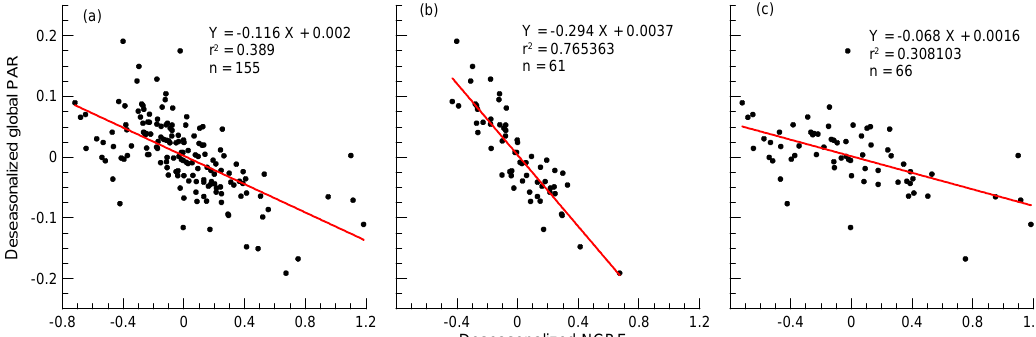
Figure 13. Scatterplot between deseasonalized global PAR and deseasonalized NCRE for all data (a) , for the months November–March (b) , and for the months May–September (c) . Least squares fitting lines are plotted in red; the best fit equation, squared correlation coefficients, and number of data points are shown in each